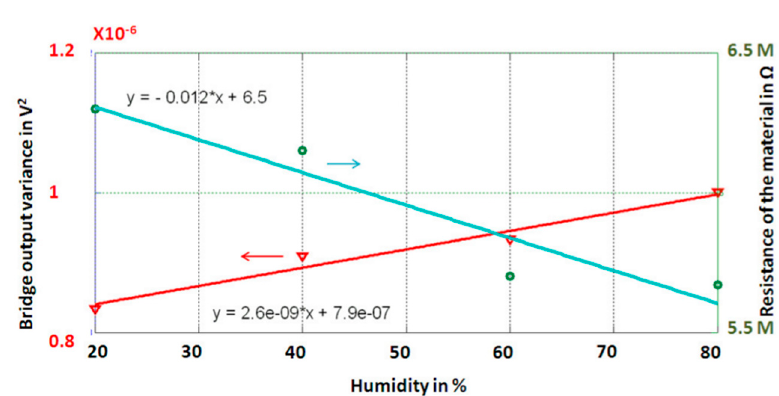
Figure 4. Validation of the redundant principle. It is possible to measure the humidity by using the variation of the output bridge (for a fixed mechanical excitation frequency) and the variation of the resistance of the